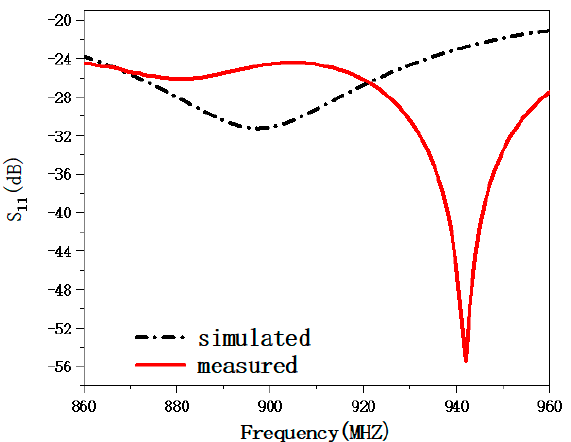
Figure 4. Reflection coefficients of the spiral antenna obtained through simulation and real-world measurements.